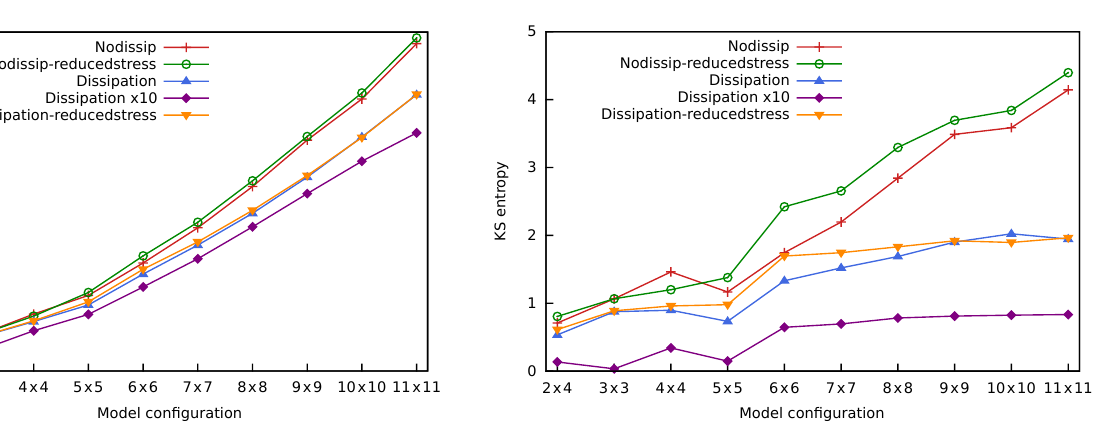
Figure 15. Kaplan–Yorke or Lyapunov dimension D KY of MAOOAM as a function of the resolution for the different exper- iments. Colours as in Fig. 10.